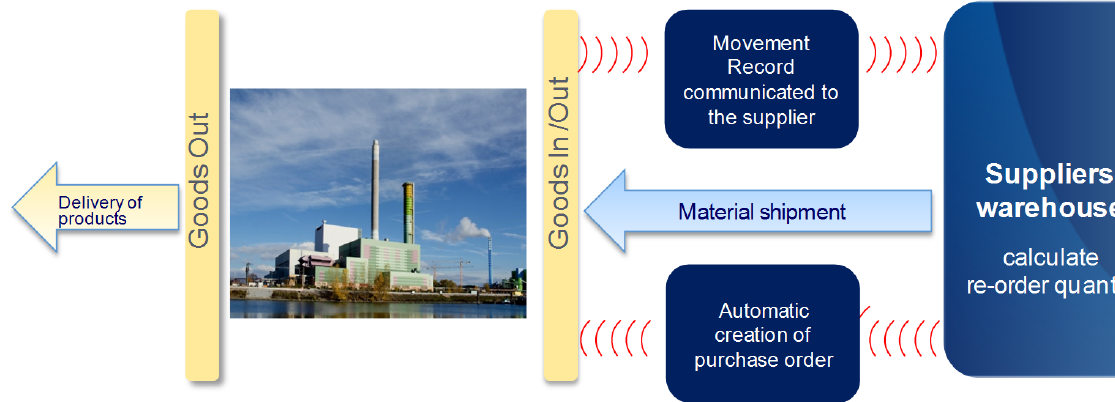
Figure 2: Process model of an It supported replenishment systemv.